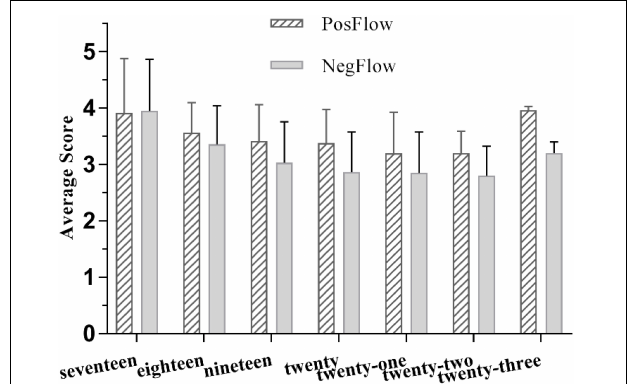
FIGURE 4 | The effects of age on PosFlow and NegFlow (Means and